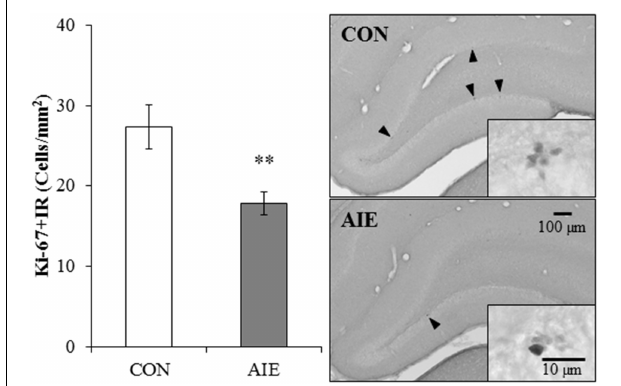
FIGURE 4 | Adolescent intermittent ethanol (AIE) treatment leads to long-term increased cleaved caspase-3 immunoreactive ( + IR) expression in the young adult hippocampus. Profile cell counts revealed a 54% ( ± 20%) increase of caspase-3 + IR cells in the hippocampal dentate gyrus of AIE-treated animals on postnatal day 80, relative to controls (CONs). Data are presented as mean ± SEM. ∗ indicates p < 0 . 05, relative to CON rats. Included are representative photomicrographs of caspase-3 + IR cells in the dentate gyrus of the dorsal hippocampus from CON- and AIE-treated animals. Arrowheads highlight cleaved caspase-3 + IR